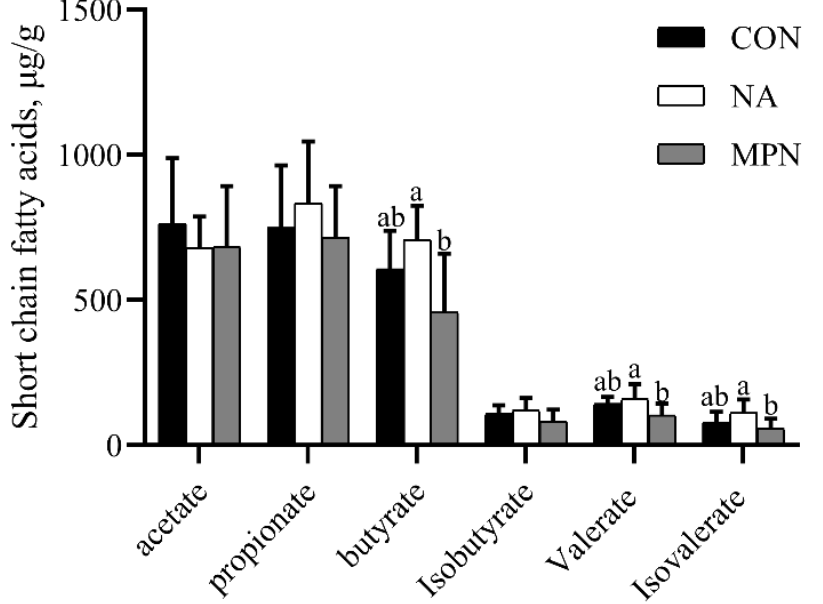
Figure 7. Effects of niacin on SCFAs levels in the colonic contents of weaned piglets. a, b Values of different superscripts in the same row mean significantly different ( p < 0.05). Values are expressed as the mean ± SD, n = 8/treatment. CON, control group; NA, niacin group; MPN, GPR109A antagonist